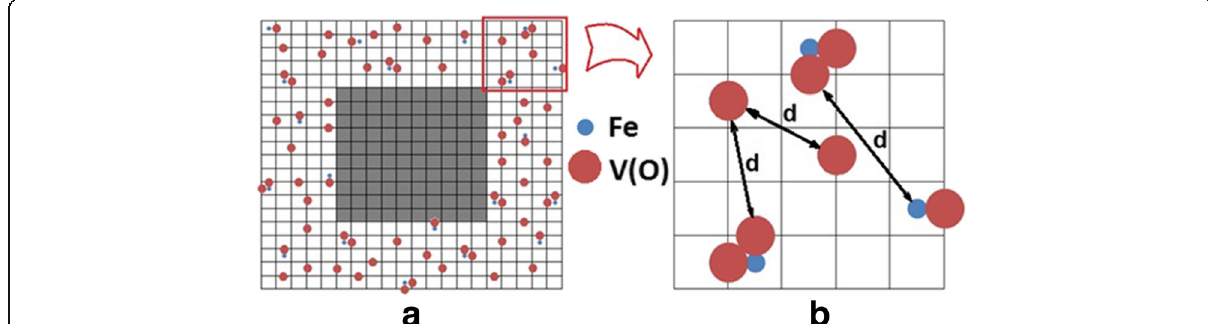
Fig. 7 Distribution of defects in the surface layer. a Light area displays the sub-surface defect layer. Gray area reflects the depth of nanoparticles, where defects are almost absent in comparison with the sub-surface layer. Proportionality between the size of sub-surface defect area and defect-free inner core is broken in this figure for more clear representation of the defects distribution in the sub-surface layer. Fe atoms are distributed uniformly in the depth of the defect layer, the oxygen vacancies V(O) are located near Fe atoms. b Zoom of the defective layer ( a ); d is the distance